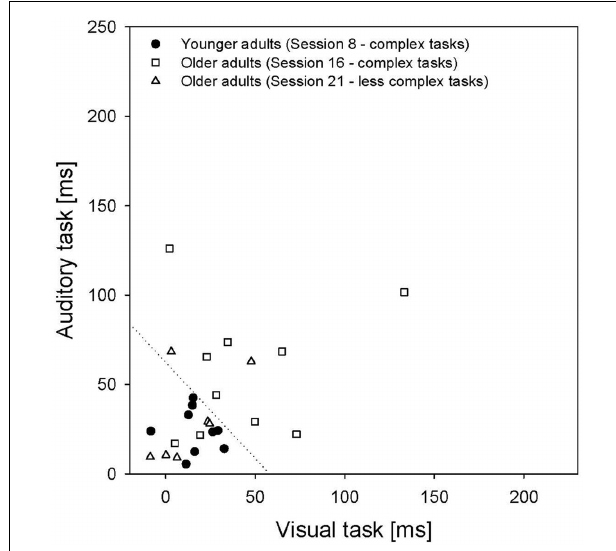
FIGURE 3 | Individual dual-task reaction time (RT) costs in younger and older adults at the end of practice (i.e., younger adults: Session 8, older adults: Session 16, 21). The x -axis represents the costs in the visual task while the y -axis represents the costs in the auditory